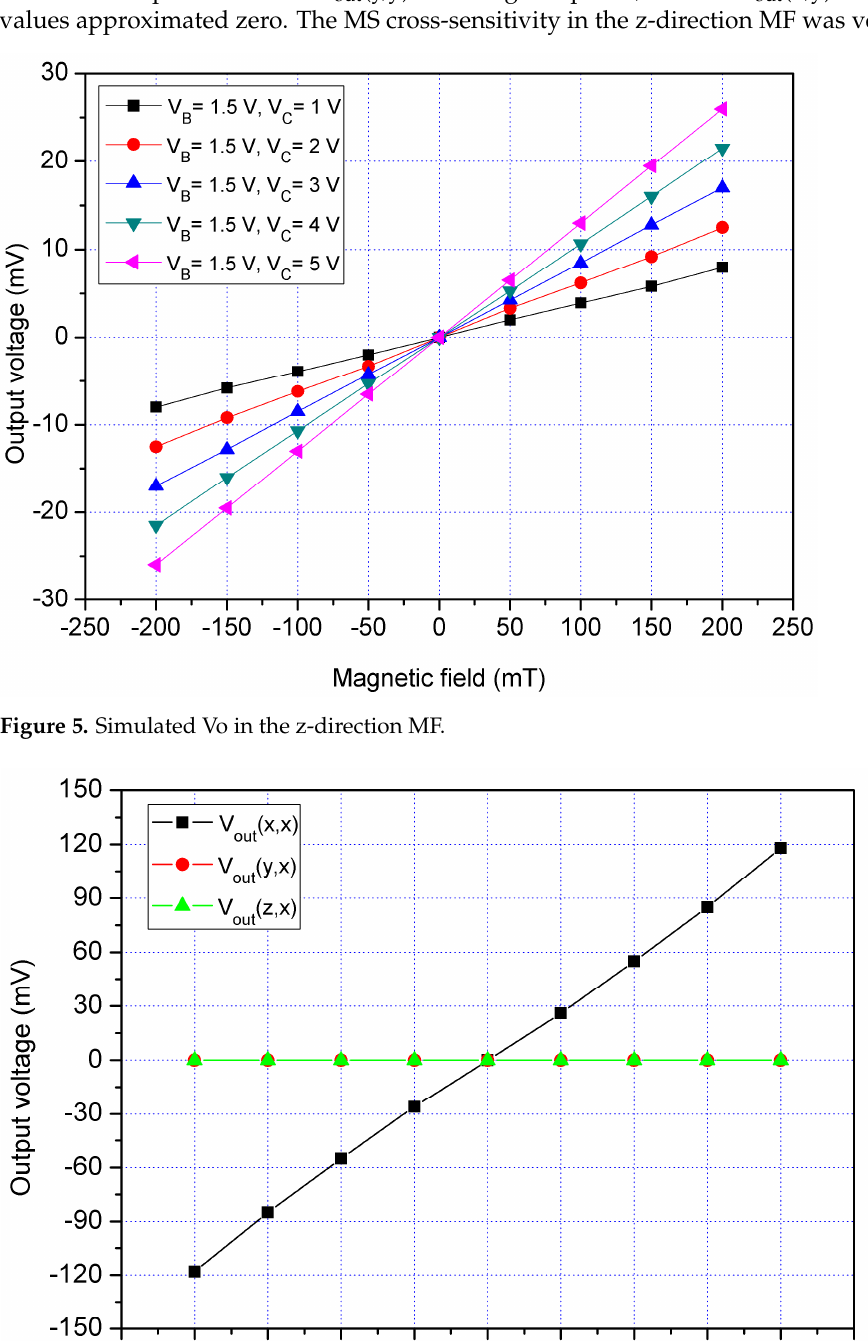
Figure 7. Simulation of output for the MS in the y-direction MF.